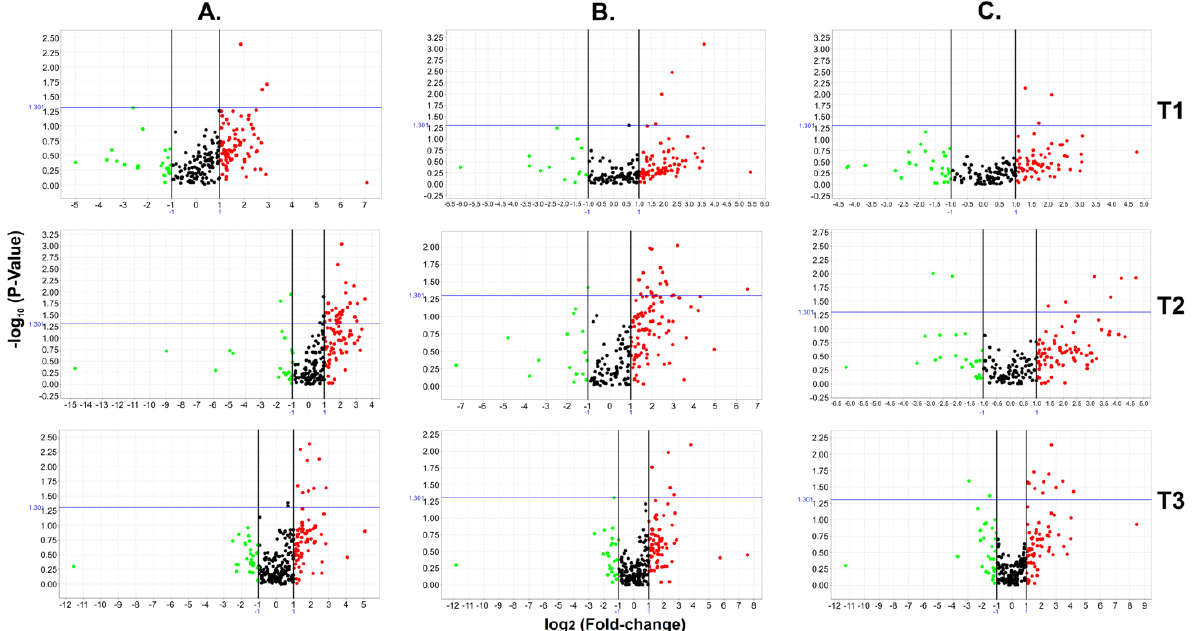
Figure 2. Circulating miRNA expression profiles from the WWD-PE and control groups. The figure shows volcano plots ( p -value vs. fold change) generated from 768 miRNAs evaluated during the three pregnancy time points (T1 – T3: T1 = 12 WG; T2 = 16 WG; T3 = 20 WG) between the WWD-PE and control groups ( A ), the WWD-mild PE and control groups ( B ), and the WWD-severe PE and control groups ( C ). Throughout the analysis, the boundary value for the fold change was 2, and the p -value boundary was 0.05. The green and red points correspond to the markers that were under- or overexpressed, while the black points represent miRNAs with expression values outside of the fixed boundaries in the analysis.